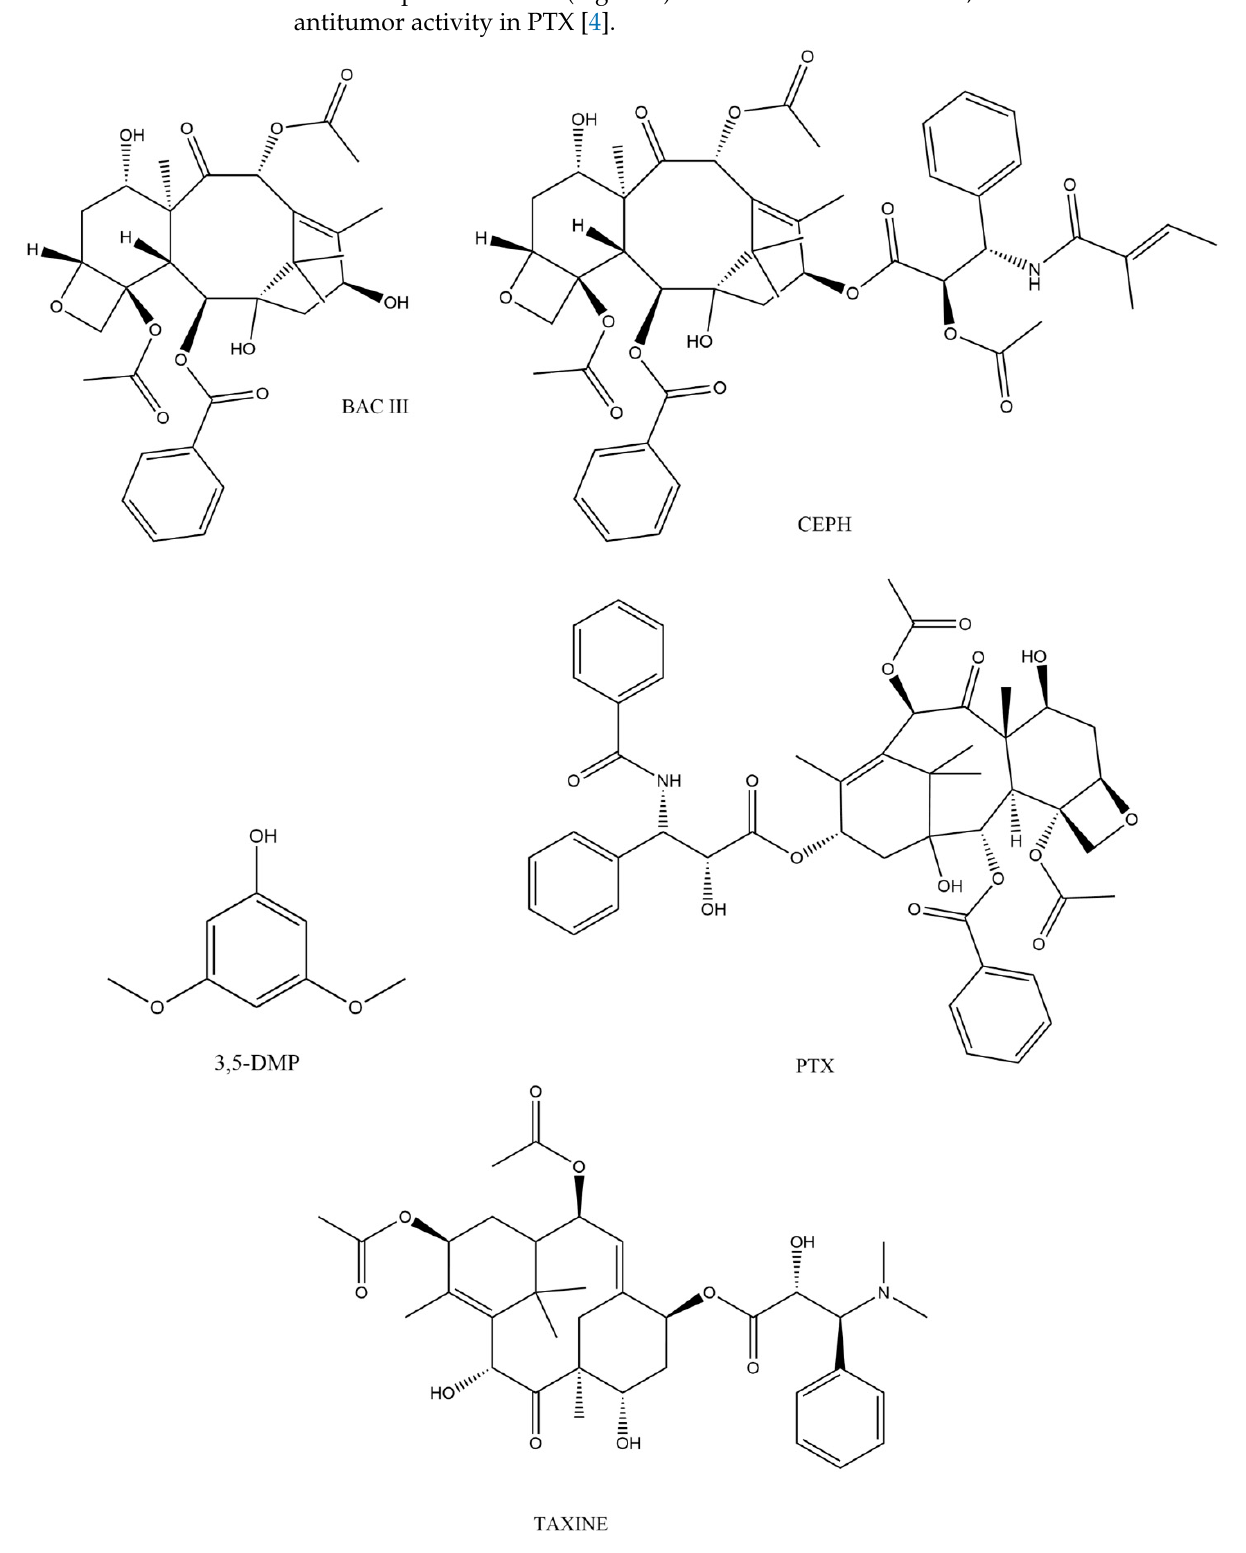
C-10 in cephalomannine (Figure 1) interact with microtubules, but are not essential for the antitumor activity in PTX [4].